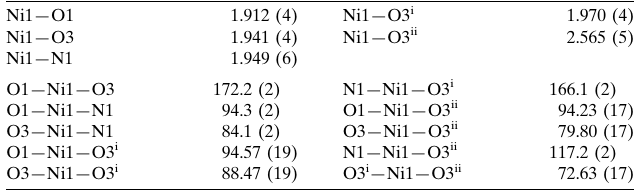
Selected geometric parameters (A˚ , (cid:4) ).